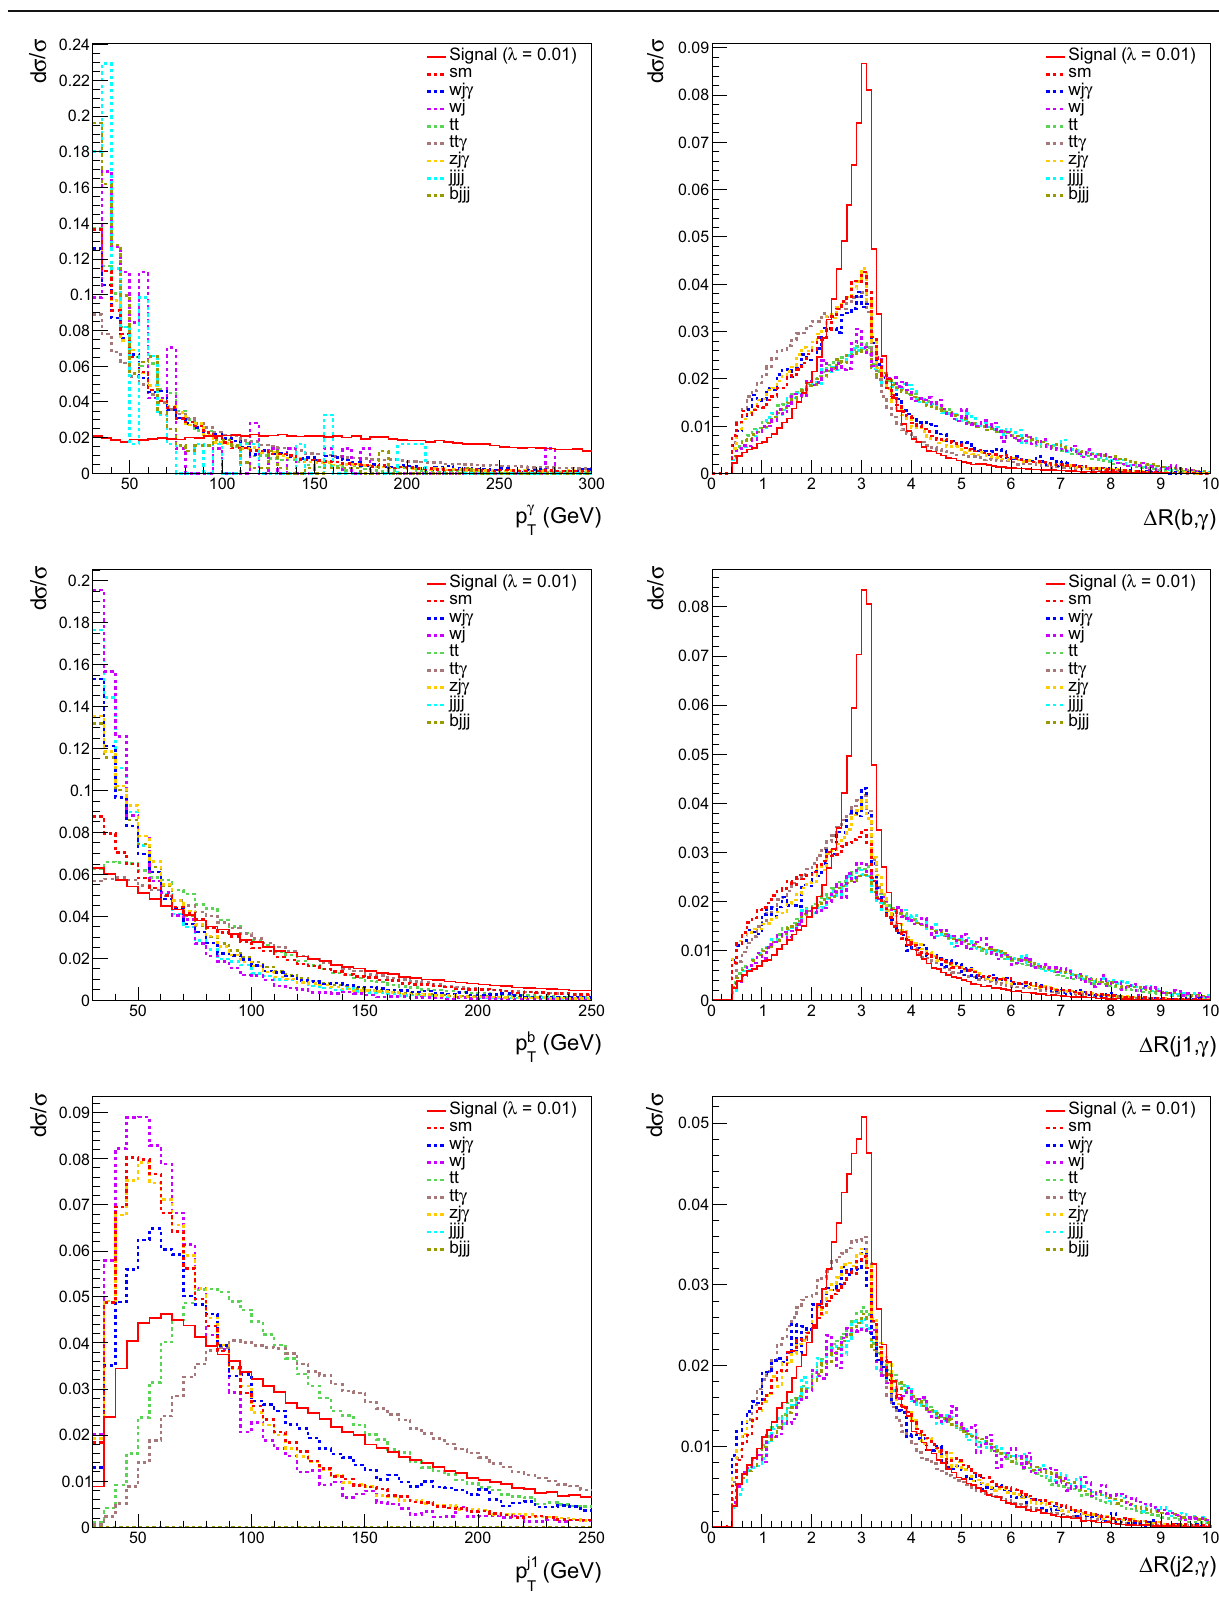
Fig. 4 The kinematic distributions of the final state particles in hadronic channel for signal ( λ q = 0 . 01) and relevant SM background processes; transverse momentum of γ , b -jet and leading jet ( j 1) on the left column and (cid:8) R ( b ,γ) , (cid:8) R ( j 1 ,γ) and (cid:8) R ( j 2 ,γ) on the right